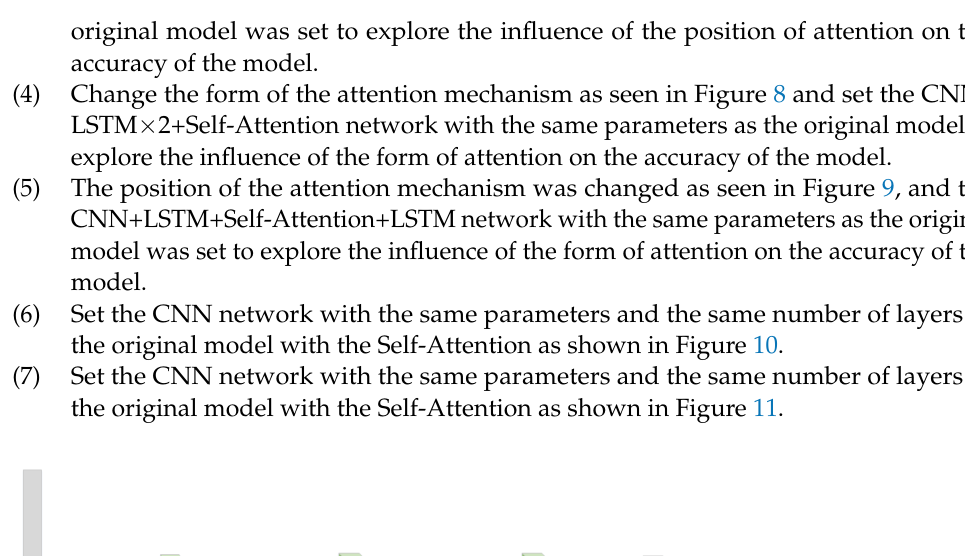
Figure 5. The construction of the CNN model.